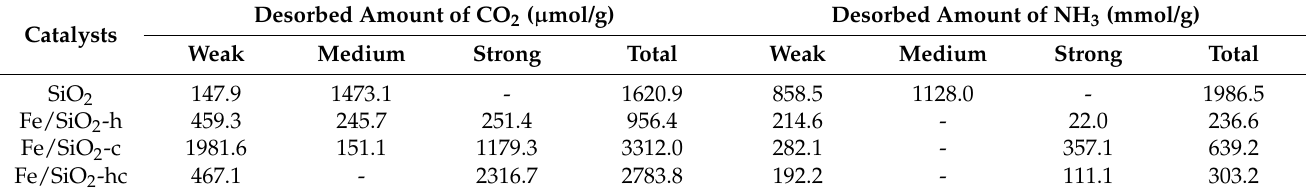
Table 3. The amount of CO 2 and NH 3 calculated from CO 2 -TPD and NH 3 -TPD profiles of all activated Fe/SiO 2